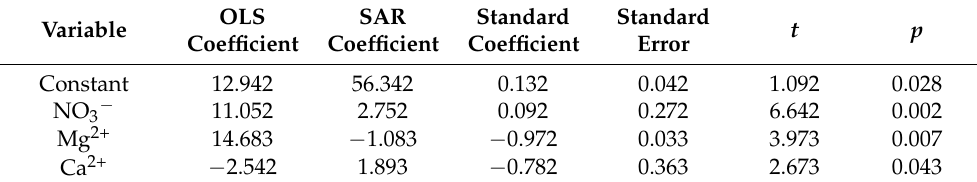
Figure 4. Curve number for suburban area.